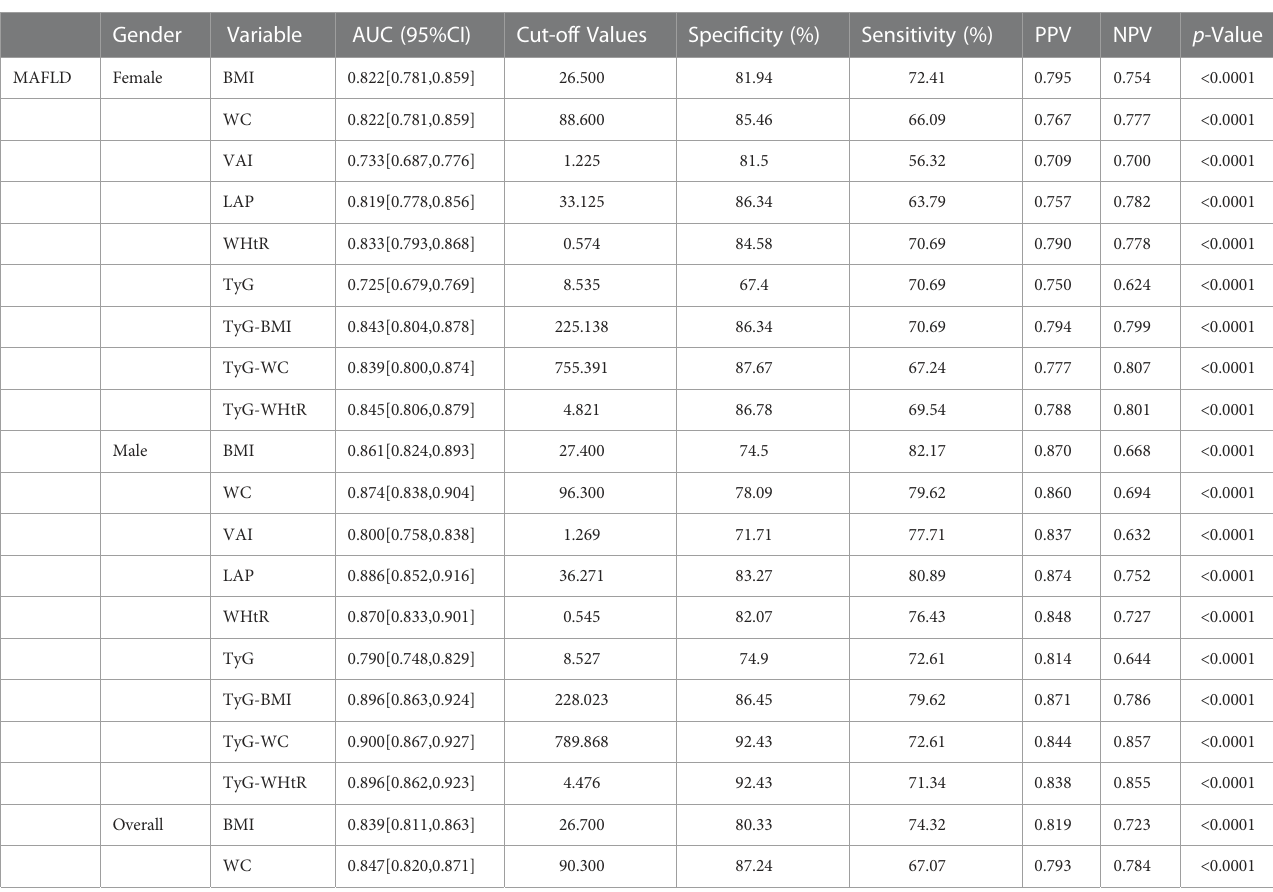
TABLE 3 Selected parameters for predicting MAFLD/NAFLD and the corresponding AUC, optimal cut-off values, their sensitivity and speci fi city, PPV and